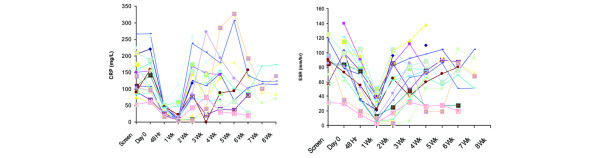
Serum C-reactive protein (CRP; mg/l) and erythrocyte sedimentation rate (ESR) of individual patients for all dose groups from day 0, pre-infusion, until the end of the follow-up period for each dose group.